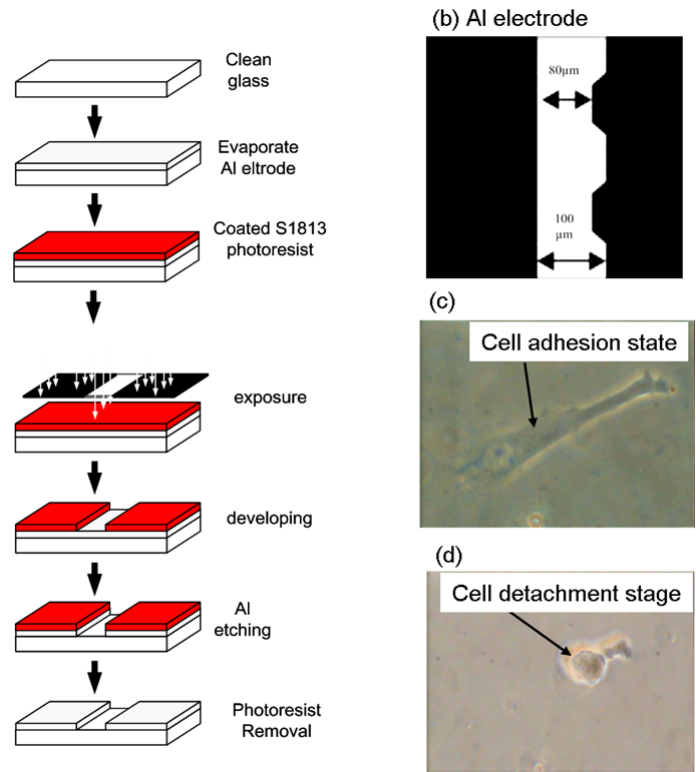
Figure 2. The manufacture scheme ( a ) and structure ( b ) of a single-layer aluminum electrode and cell morphology before ( c ) and after cell detachment ( d